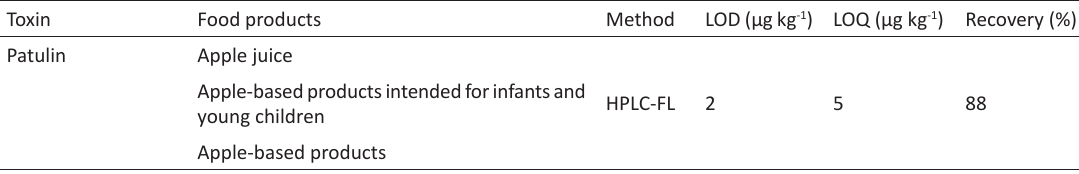
Table 2 . Performance parameters to patulin and food